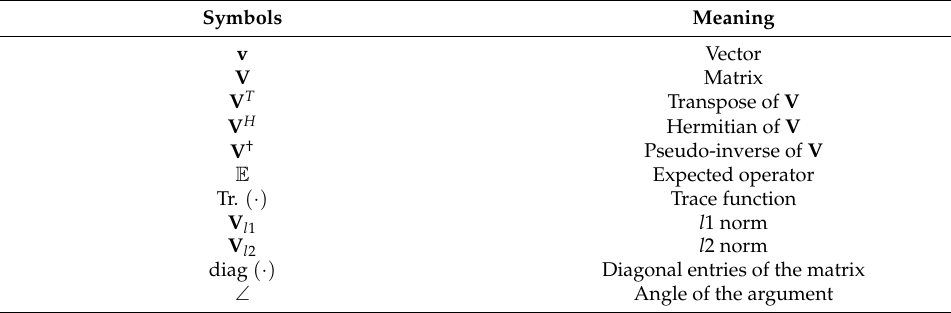
Table 2. Summary of main